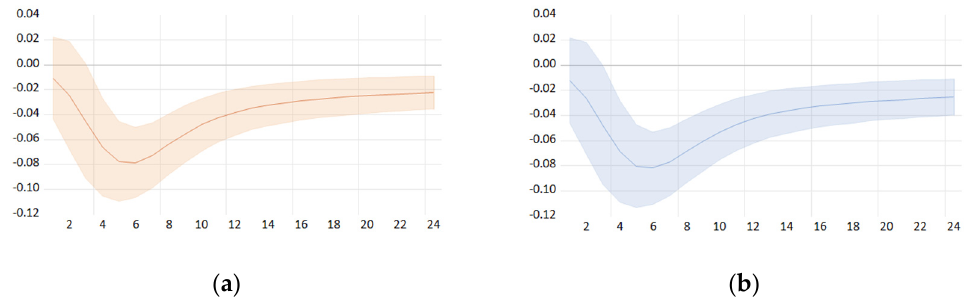
Figure 1. Time-invariant impulse response of housing prices to higher interest rates. ( a ) Based on the Korea Real Estate Board Price Index, ( b ) based on KB Price Index. Note: the horizontal axis represents the impulse response period (months), and the vertical axis represents the response (%) to a 1SD interest rate shock. Source: estimated by the authors with the VAR model.